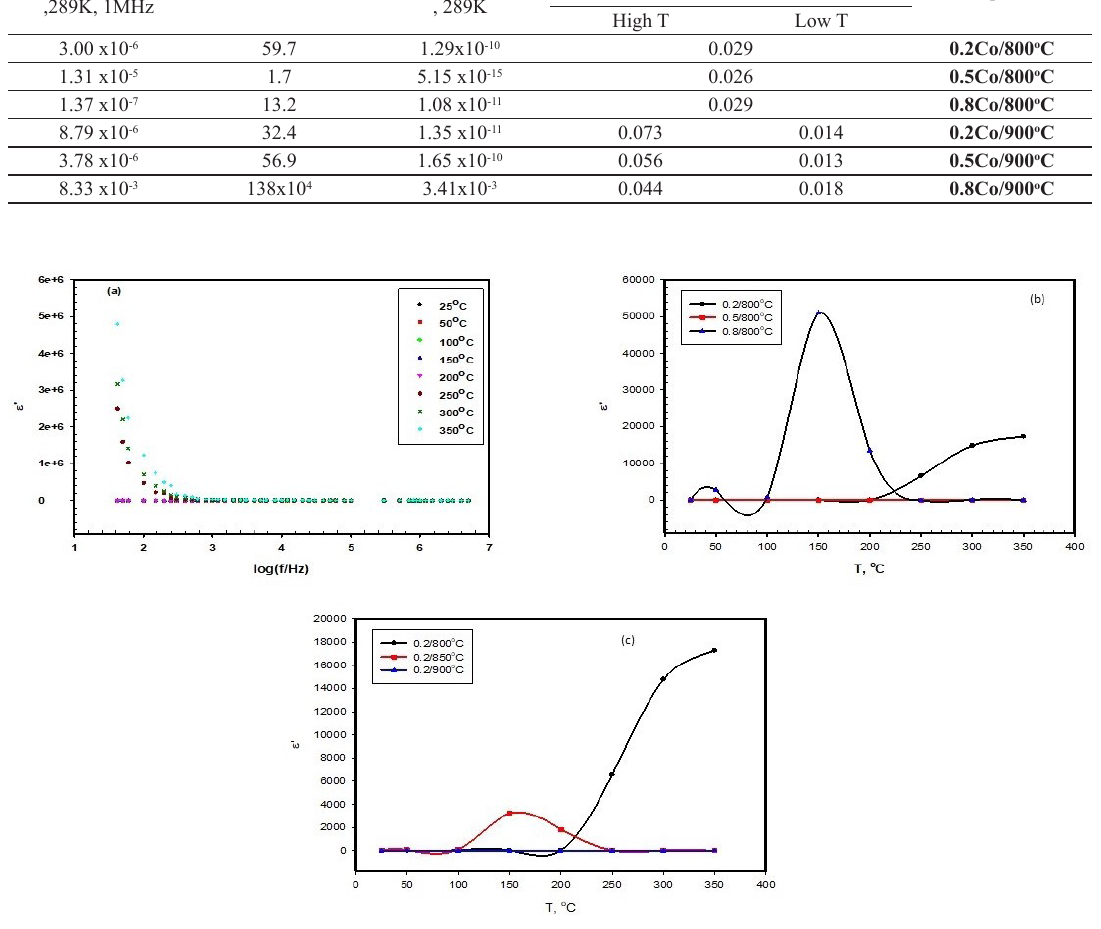
Figure 7. (a) The frequency and temperature dependence of the dielectric constant (έ) for Co sintered at 800 o C/2hr (b) The dependence of dielectric constant on the composition at 10 KHz (c)) The dependence of dielectric constant for Co Zn Fe O on the sintered temperatures at 0.2 0.8 2 4